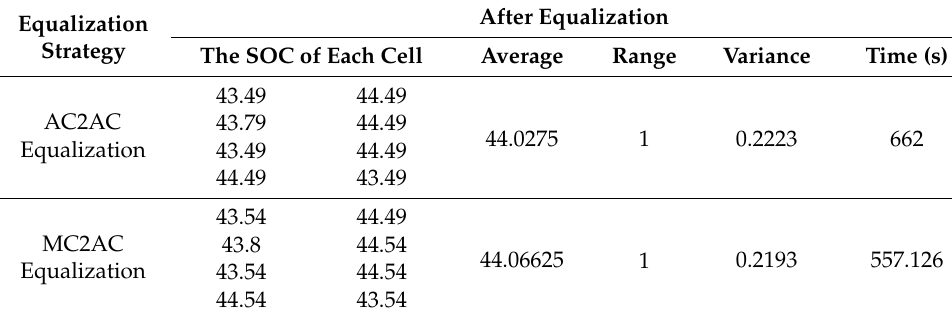
Figure 18. ( a ) AC2AC equalization simulation results ( b ) MC2AC equalization simulation results. Table 3. Equalization results for AC2AC and MC2AC control strategies.